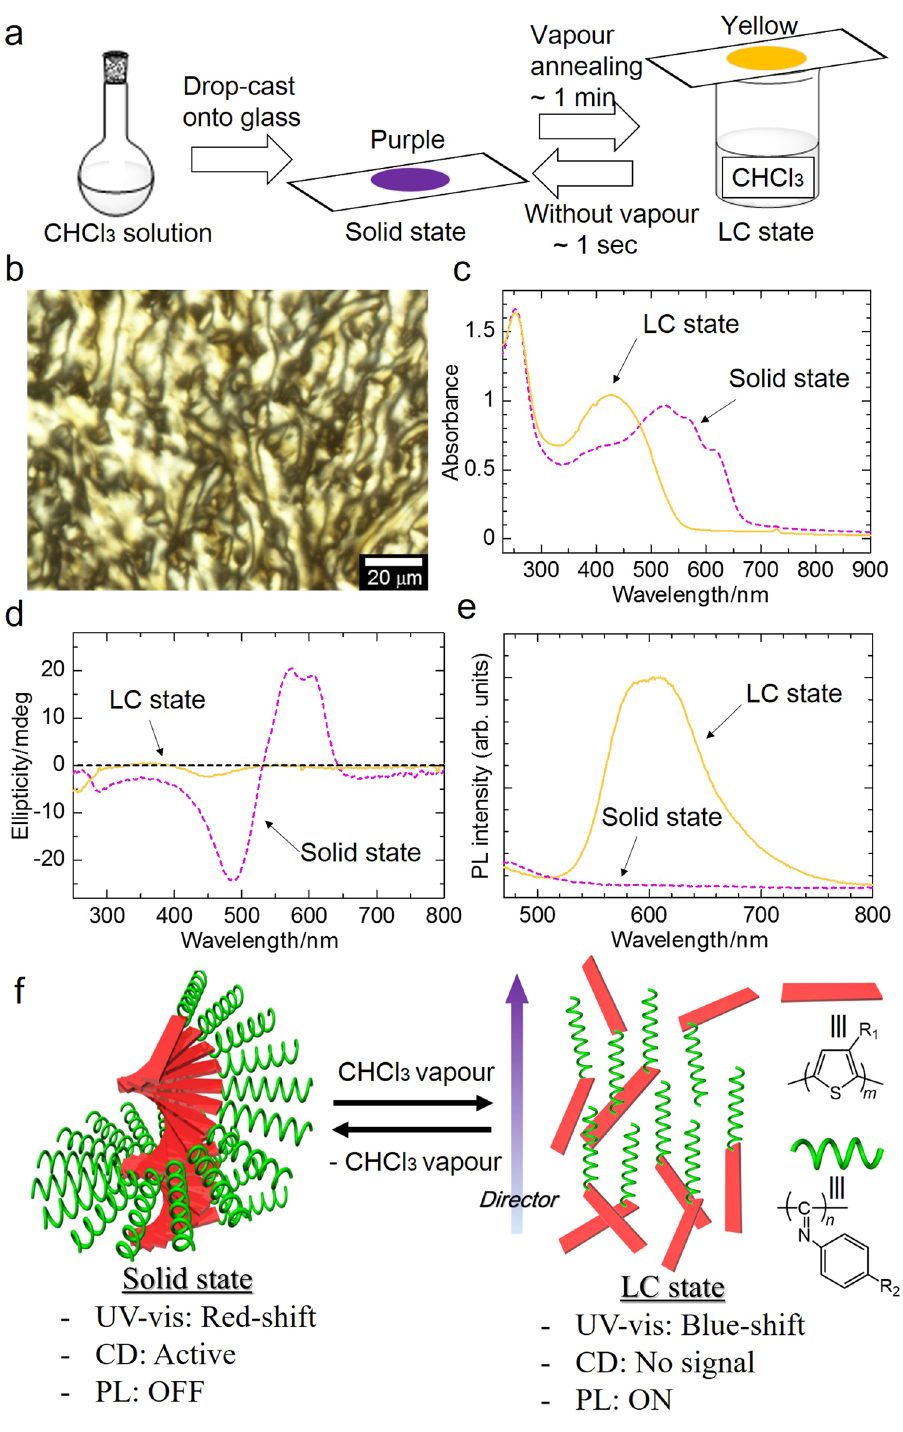
Figure 3. Vapour-induced liquid crystallinity of PTh- b -PPI. ( a ) Schematic representation of PTh- b -PPI film preparation and vapour exposure. The film shows purple in solid state and yellow in liquid crystal (LC) state (under chloroform vapour). ( b ) Polarising optical microscopy (POM) image of PTh- b -PPI film in LC state (when exposed to chloroform vapour). ( c ) Absorption, ( d ) CD and ( e ) PL spectra ( λ ex = 420 nm) of PTh- b -PPI film in solid state and LC state. ( f ) Schematic illustration of reversible phase-transition behaviour between solid state and nematic-like LC state of PTh- b -PPI . PPI blocks serve as mesogens and have orientation along the